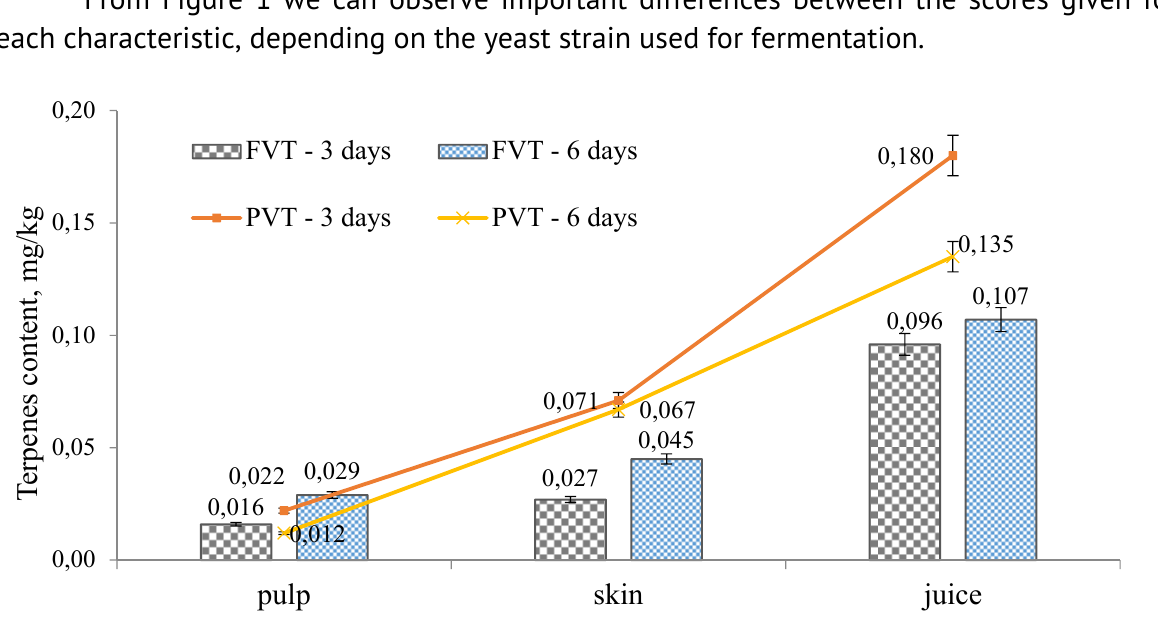
Figure 1. Distribution of FVT and PVT in different parts of Viorica variety